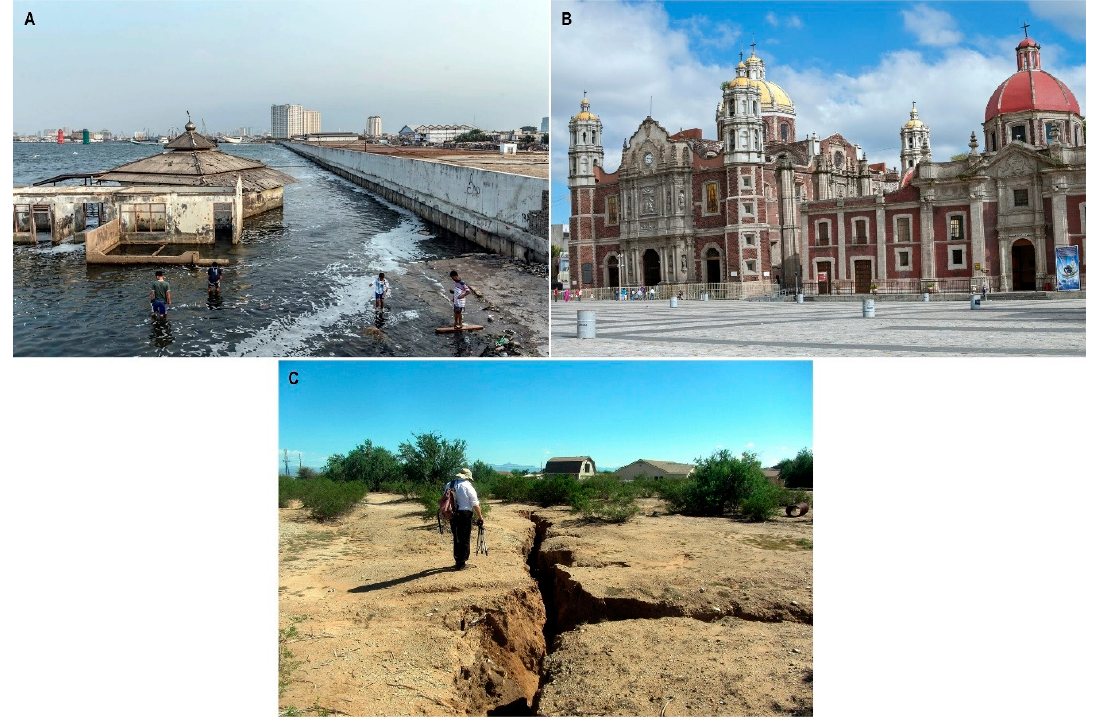
Figure 2. Adverse effects of over-exploitation of groundwater: ( A ) the increase in the risk of flooding in Jakarta; the combined effects of both land subsidence and the increase in the average ocean level caused the need to build a sea wall to protect the city from floods, especially during stormy periods (photo credit by Graham Crouch [55]); ( B ) the twist and deformation of surface infrastructure in Mexico City; some buildings have been deemed unsafe and have been closed, and many others have needed repairs to keep them intact; land subsidence affected historic urban areas, including the Metropolitan Cathedral (photo credit by Czuber [56]); ( C ) an earth fissure in a farmland area of Chandler Heights, Phoenix, Arizona (courtesy of the Arizona Geological Survey, photo by Joseph Cook [57]).